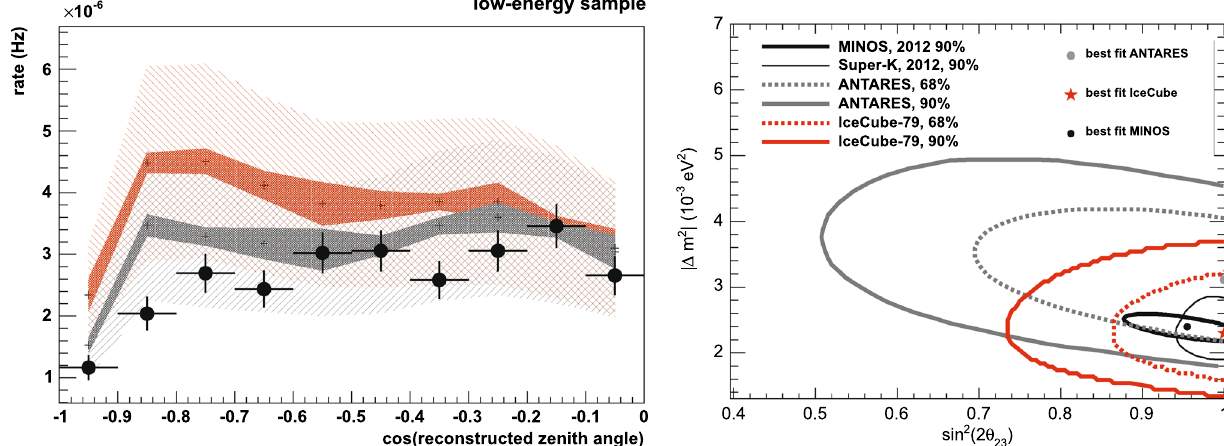
Fig. 6 Left panel: angular distribution of contained events in Deep- (dashedareas)andtheshapecontribution(filledareas)foreachassump- tion shown. Right panel: significance contours at 68% and 90% CL for Core (i.e., with energies between approximately 10 GeV and 60 GeV), the best-fit values of the IceCube analysis (red curves), compared with compared with the expectation from the non-oscillation scenario (red results of the ANTARES [70], MINOS [71] and Super-Kamiokande area) and with oscillations (grey area) assuming current best-fit values | = 2 . 39 × 10 − 3 eV 2 and sin 2 ( 2 θ ) = 0 . 995, from [69]. [72] experiments. Figures reprinted with permission from Ref. [73] of | (cid:18) m 2 23 32 (Copyright 2013 Systematic uncertainties are split into the normalisation contribution